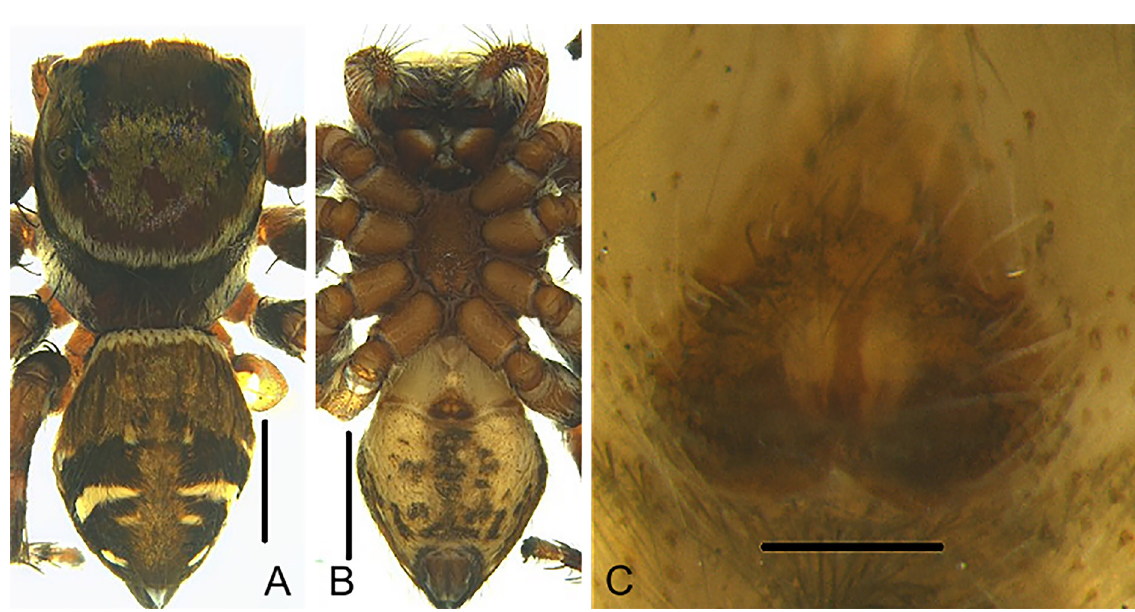
Fig 3. Carrhotus albosetosus sp. nov., female. A . Habitus, dorsal view. B . Habitus, ventral view. C . Epigynum. Scale bars: A–B = 2 mm; C = 0.1